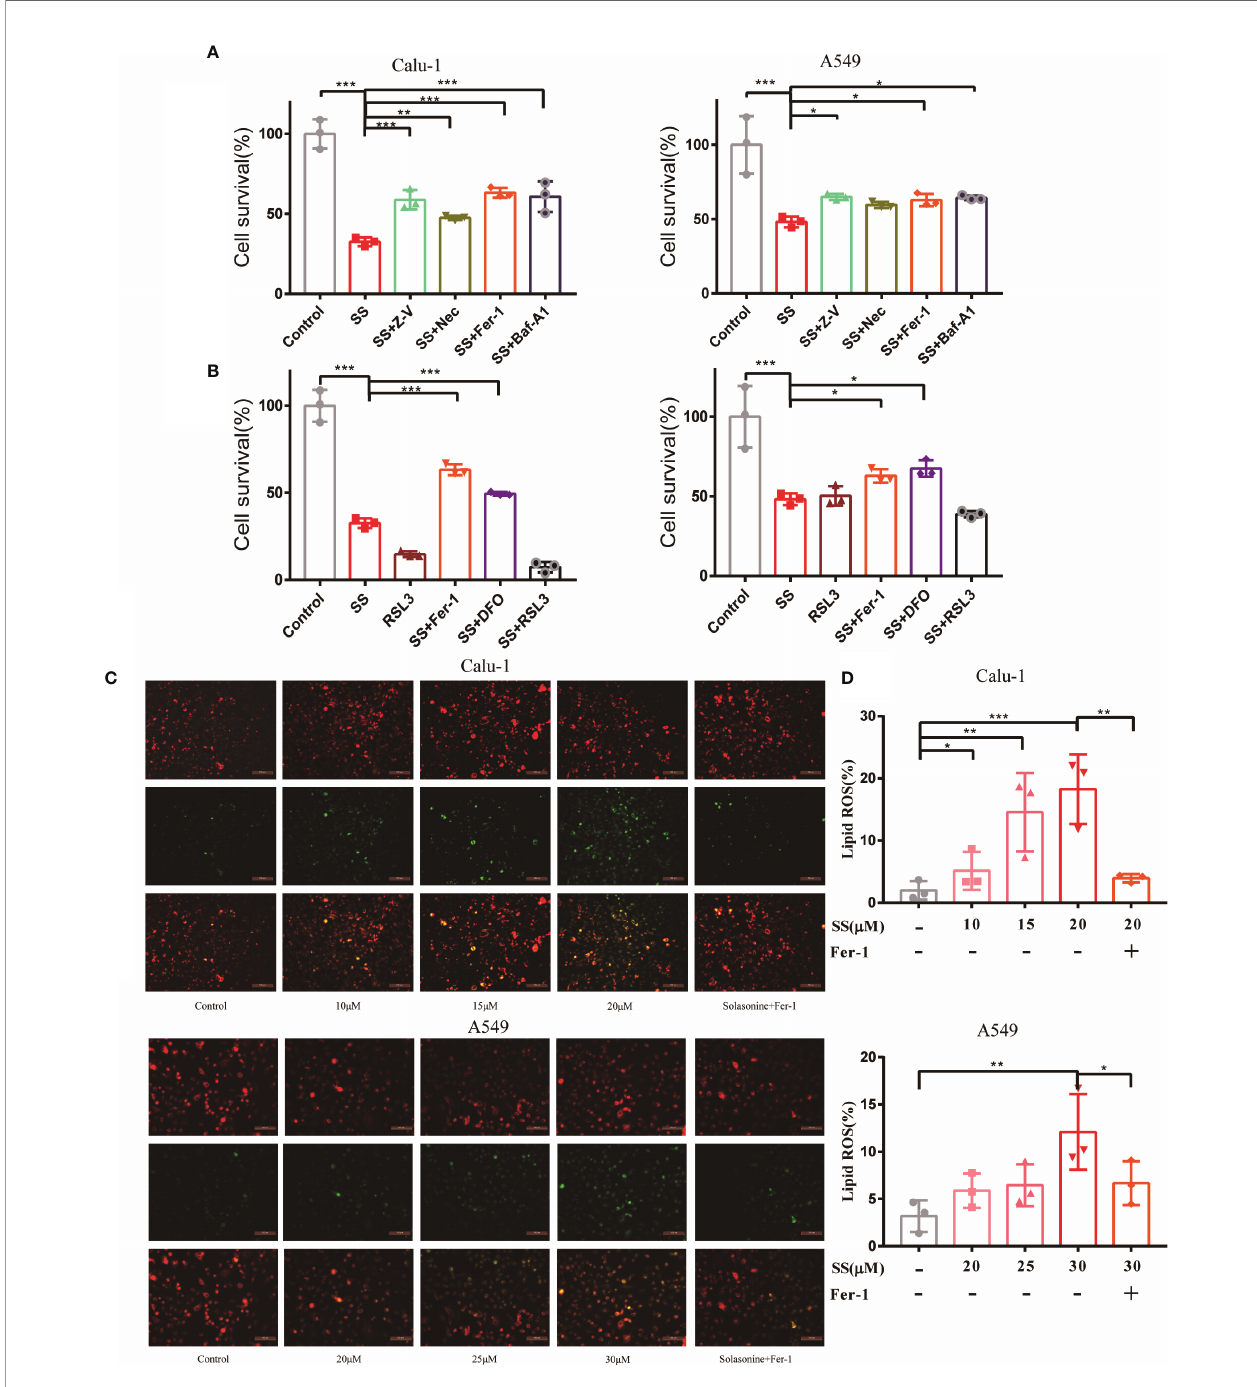
FIGURE 2 | Ferroptosis contributed to solasonine-induced cell death in LUAD cells. (A, B) CCK8 assay was used to determine the cell viability of Calu-1 or A549 cells treated with 20 m M or 30 m M SS, respectively, with or without pretreatment of Z-V (20 m M), Nec (30 m M), Fer-1 (1 m M), Baf-A1 (100 nM), RSL3 (0.5 m M), and DFO (80 m M). (C) Fluorescence microscopy was used to detect the lipid ROS in Calu-1 or A549 cells, which were respectively treated with 10, 15, 20 m M or 20, 25, 30 m M SS for 6 h and pretreated with or without Fer-1(1 m M). Scale bars: 100 m m. (D) Flow cytometry was used to detect the double signals of C11-BODIPY581/ 591, which were then digitized and analyzed using histogram statistics. (*P < 0.05, **P < 0.01, ***P <